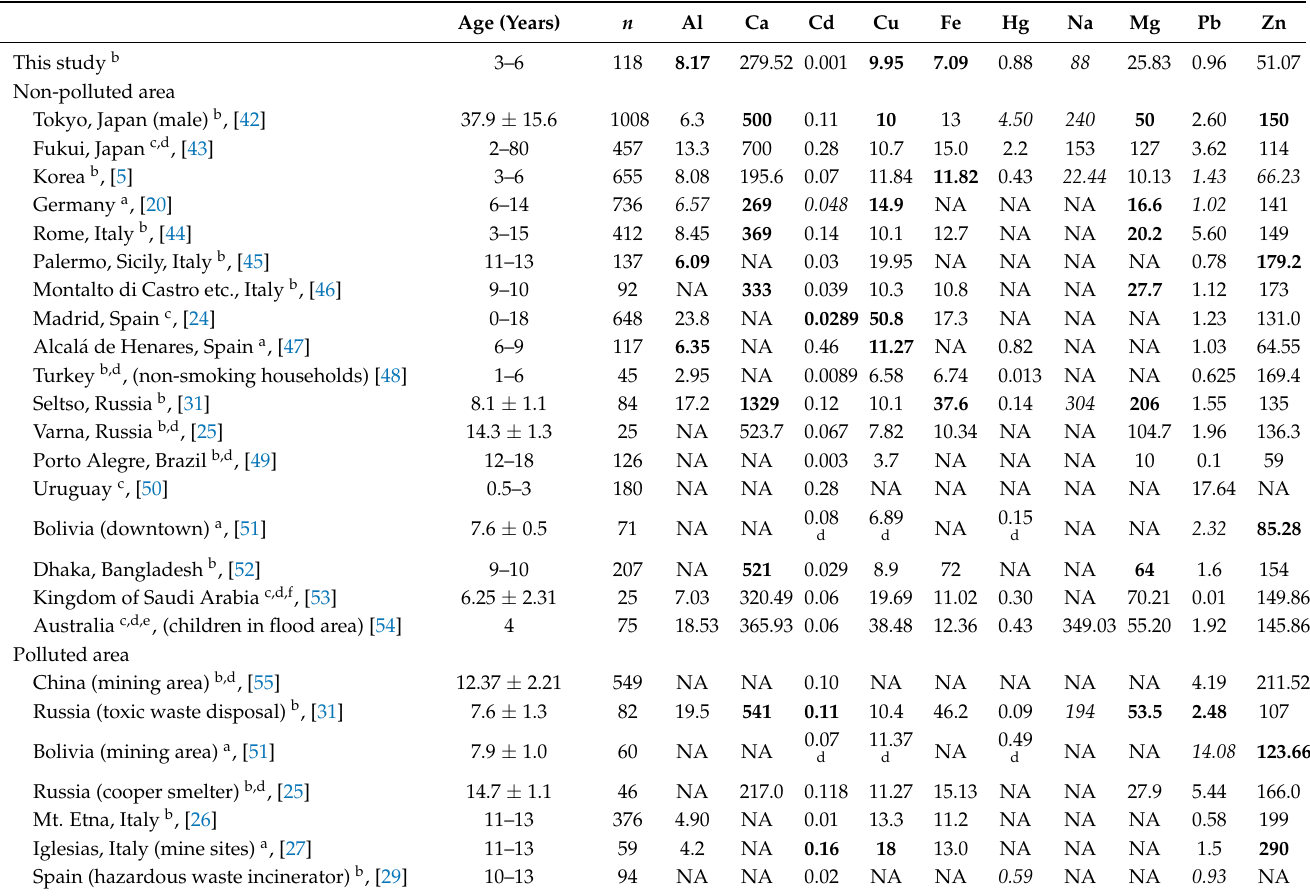
Table 7. Summary of studies reporting trace elements’ concentrations in hair of children from other countries ( µ